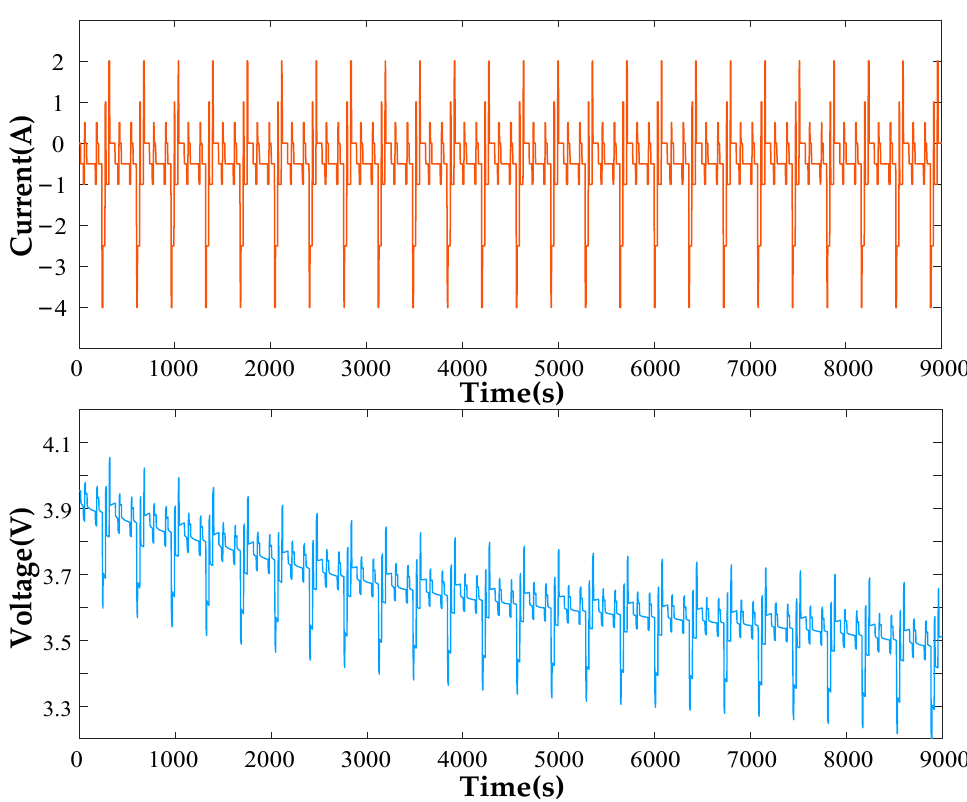
Figure 4. The current and the terminal voltage of the lithium battery from DST.